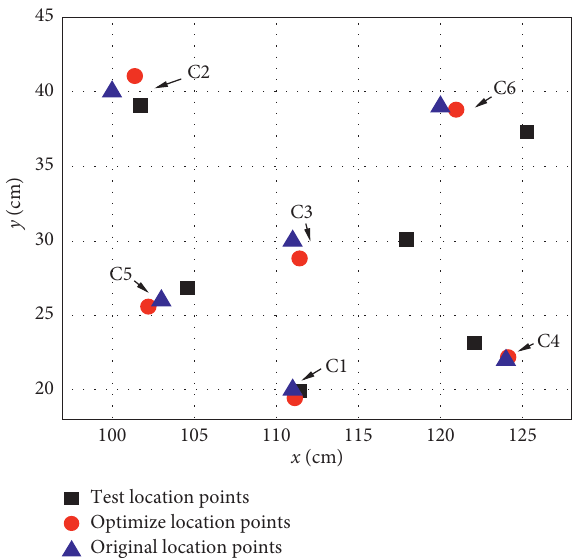
Figure 16: The comparison of comprehensive location points. Table 18: Time differences among different sensors determined based on cross-correlation wavelet packet decomposition. Focal